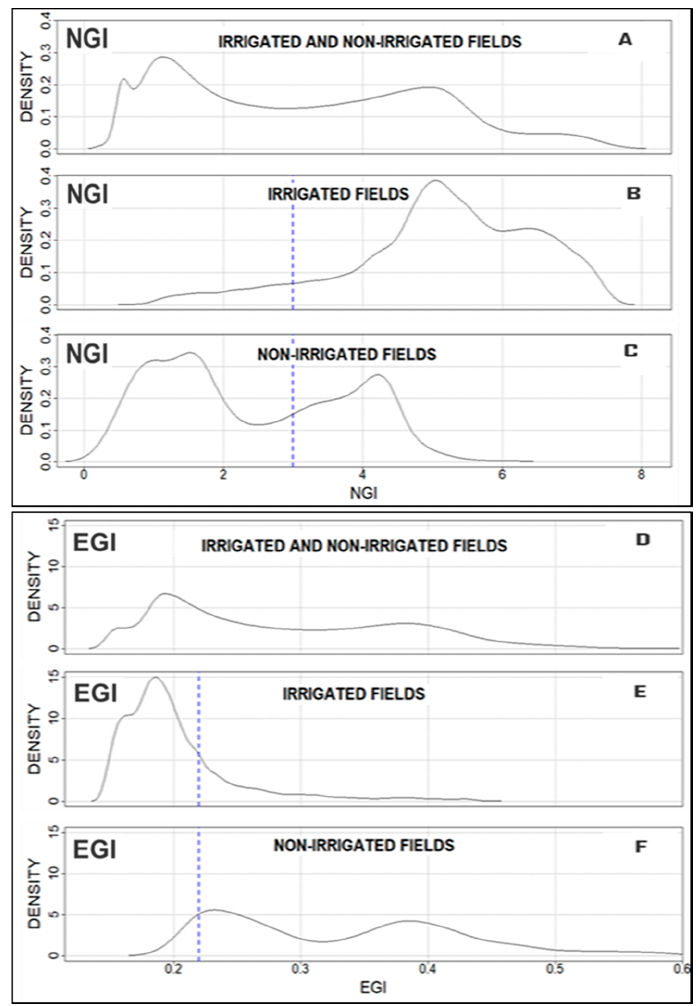
Figure 4. Empirical distributions of NGI and EGI indices for all fields combined (Irrigated and non-irrigated areas), irrigated, and non-irrigated areas. Redlines indicate the threshold values of NGI and EGI.